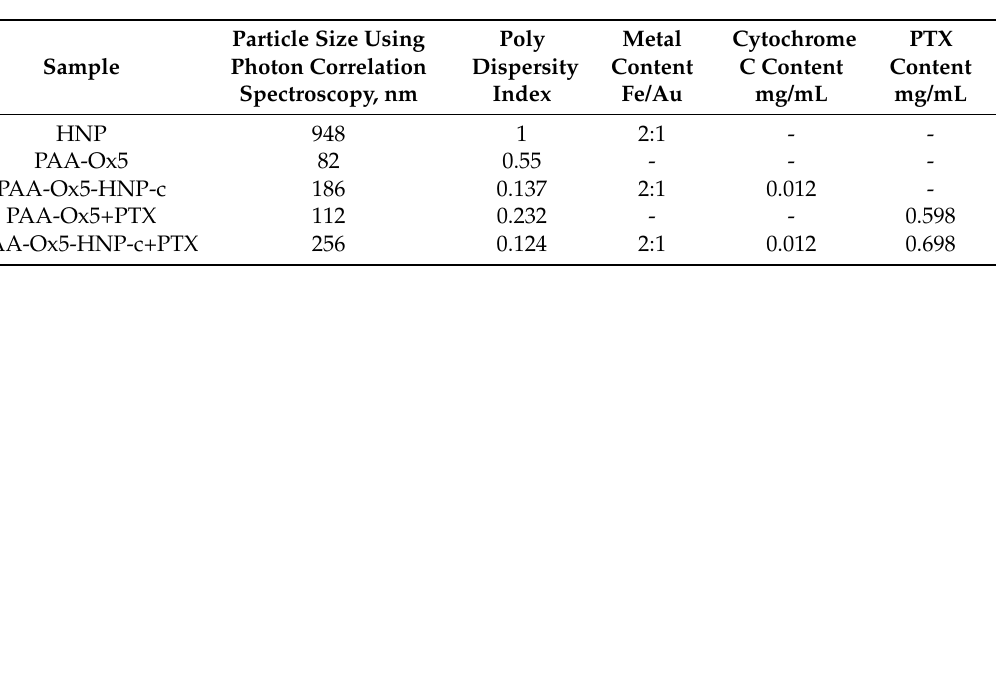
Figure 3. Physical characterisation. Transmission electron microscopy (TEM) images of ( A ) HNPs, ( B ) PAA-Ox5, and ( C ) PAA-Ox5-HNP. ( D ) Ultraviolet visible (UV-Vis) spectroscopy of HNPs, ( E ) surface